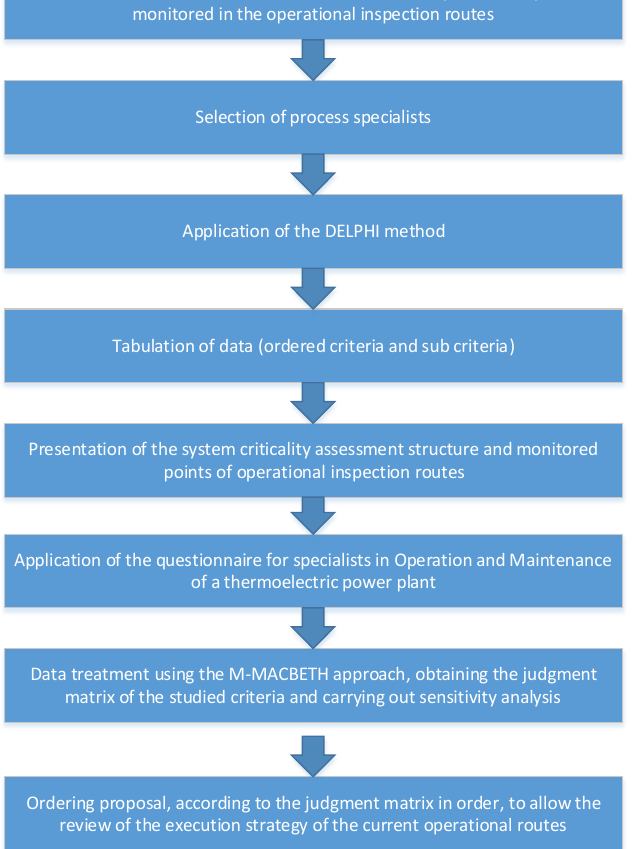
Figure 3. Flowchart/algorithm to illustrate the stages of methodology